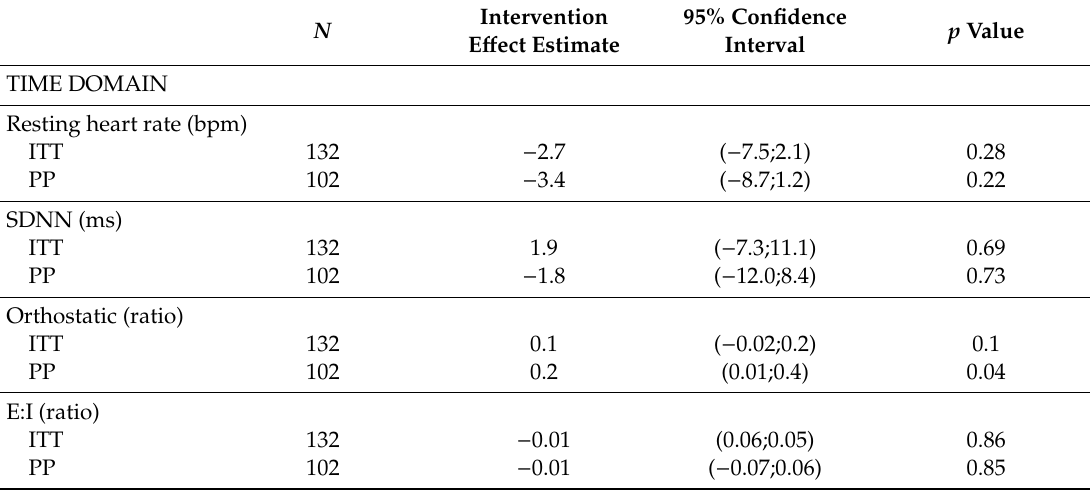
Table 3. Intervention e ff ect estimates (95% confidence interval) for the ITT and PP population.